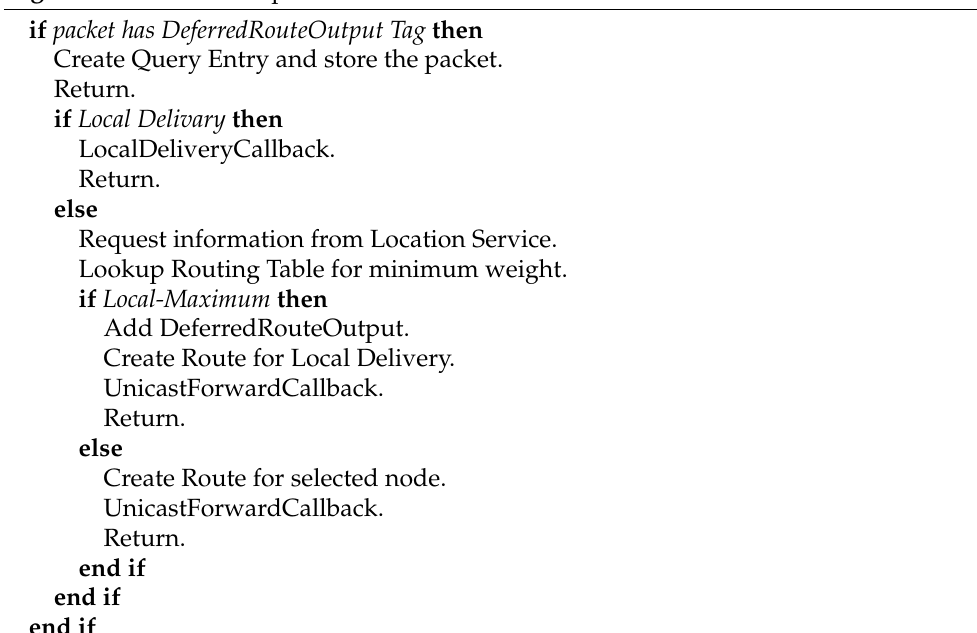
Algorithm 2 A received